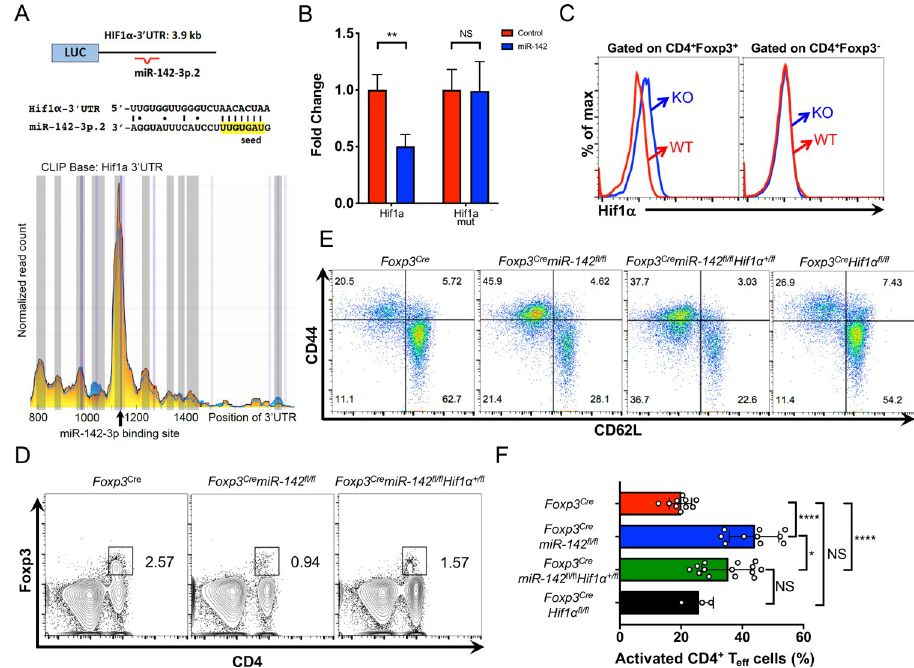
Fig 6. Lowering the Hif1a gene dose partially restores the normal size of T reg population and attenuates hyperactivation of peripheral T cells in Foxp3 Cre miR-142 fl/fl mice. ( A ) Diagram (top panel) and sequence alignment (middle panel) of miR-142-3p putative binding site in the Hif1a 3 0 UTR. HITS-CLIP analysis (bottom panel) of Ago2 binding sites in the Hif1a 3 0 UTR in activated CD4 + T cells (blue plot, WT; yellow plot, miR-155 KO). Note the peak of Ago2 binding activity that corresponds to the predicted miR-142-3p binding site (depicted by arrow). ( B )Validation of Hif1a as direct miR-142-3p target by the 3 0 UTR luciferase reporter assay. Relative expression of WT and miR-142-3p seed mutated Hif1a 3 0 UTR reporter constructs upon cotransfection with either miR-142 precursor expressing plasmid or empty vector control. Expression of WT Hif1a 3 0 UTR reporter in the presence of empty vector was arbitrarily set to 1. ( C )Intracellular FACS analysis of Hif1 α expression in CD4 + Foxp3 + and CD4 + Foxp3 - T cells from Foxp3 Cre (red line) and Foxp3 Cre miR-142 fl/fl (blue line) spleens. ( D )FACS analysis of splenic lymphocytes from 12- to 18-week-old Foxp3 Cre , Foxp3 Cre miR-142 fl/fl , and Foxp3 Cre miR-142 fl/fl Hif1a +/fl mice with anti-CD4 and anti-Foxp3 specific antibodies. Foxp3 + CD4 + T reg cells are gated, and numbers indicate the percentage of cells in the gate. ( E )FACS analysis of CD44 and CD62L expression in splenic CD4 + T cells from Foxp3 Cre , Foxp3 Cre miR-142 fl/fl , Foxp3 Cre miR-142 fl/fl Hif1a +/fl , and Foxp3 Cre Hif1a fl/fl mice. Numbers indicate percentage of cells in the quadrants. ( F )Frequency of activated (CD44 + CD62L − ) splenic CD4 + T cells in Foxp3 Cre ( n = 10), Foxp3 Cre miR-142 fl/fl ( n = 10), Foxp3 Cre miR-142 fl/fl Hif1a +/fl ( n = 14), and Foxp3 Cre Hif1a fl/fl ( n = 3) mice. Results are shown as mean ± SD. P values were calculated using 2-tailed Student t test. � , P < 0.05; �� , P < 0.01; ���� , P < 0.0001; NS, not significant. WT, Foxp3 Cre ; KO, Foxp3 Cre miR-142 fl/fl . The underlying numerical raw data can be found in S1 Data file. The underlying flow cytometry raw data can be found at the Figshare repository.FACS, fluorescence activated cell sorting; Hif1a ,hypoxia-induced factor 1 alpha; KO, knockout; SD, standard deviation; WT,